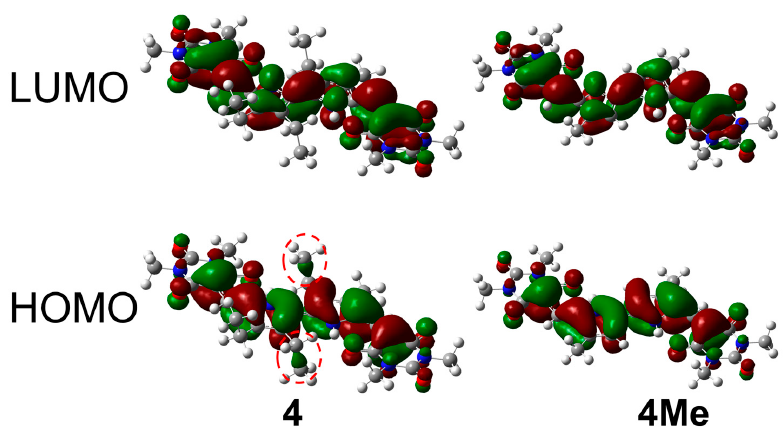
Figure 6. LUMO ( top ) and HOMO ( bottom ) orbitals (isovalue of 0.02) of compounds 4 and 4Me . The red and green surfaces show positive and negative wave functions, respectively. The broken red circles show ethyl groups at the 3 and 3 ′ positions.